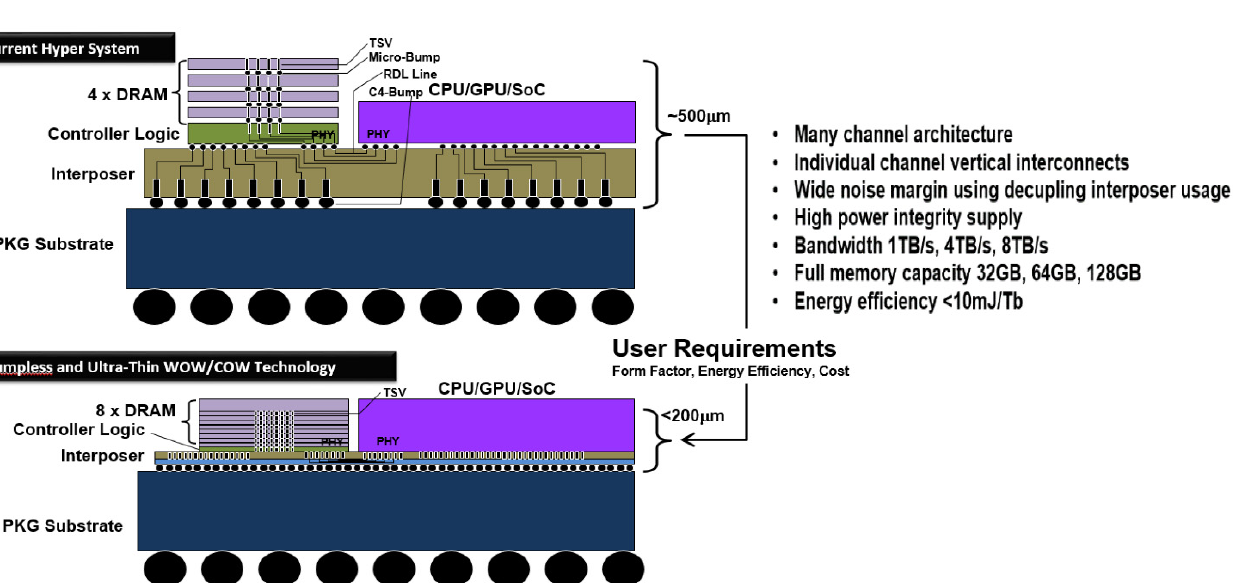
Figure 37. Data bandwidth roadmap [82–87]. Figure 38. I/O power efficiency.